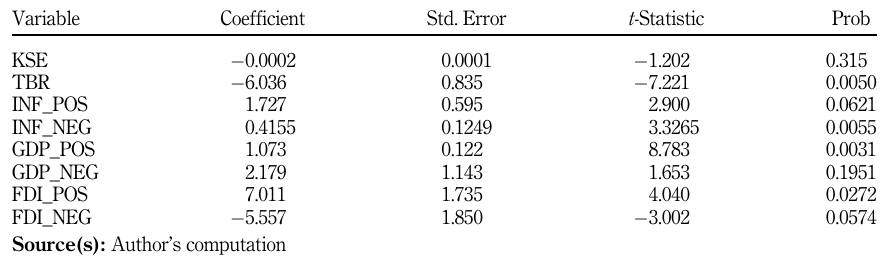
Table 7. Long-run coefficients of asymmetric ARDL